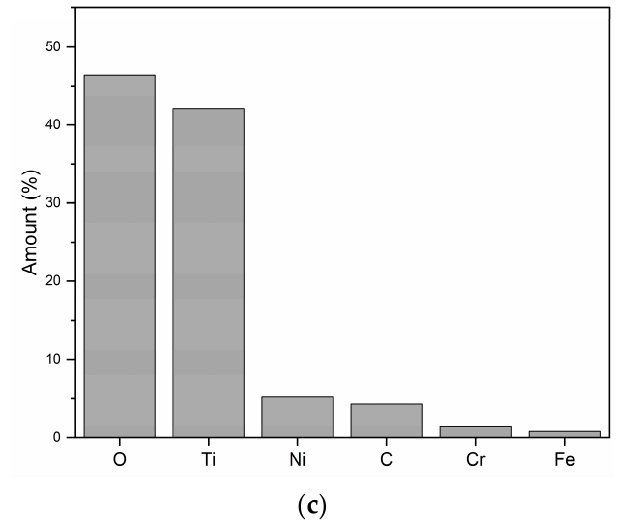
Figure 3. SEM micrographs of single-pass sprayed (0.3 M) TiO 2 solution using different stand-off distances: ( a ) 40 mm; ( b ) 60 mm. ( c ) Elemental composition of single-pass spray deposits at a 40 mm distance (arrow indicated in ( a )).